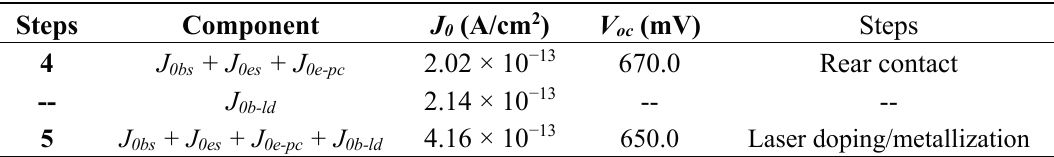
Table 8. J 0 and V oc of the thin silicon solar cell after the front surface laser doping and metallization. J 0b-ld is the reverse saturation current density introduced by the laser doping and metallization on the front surface.